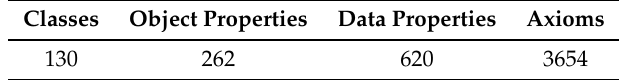
Table 6. Overview (in number of occurrences) of the OWL-DL file